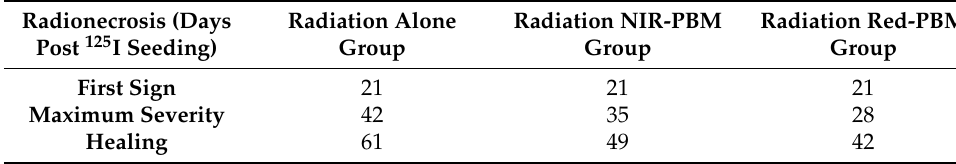
Table 1. Time course of radionecrosis lesion in animal study groups.